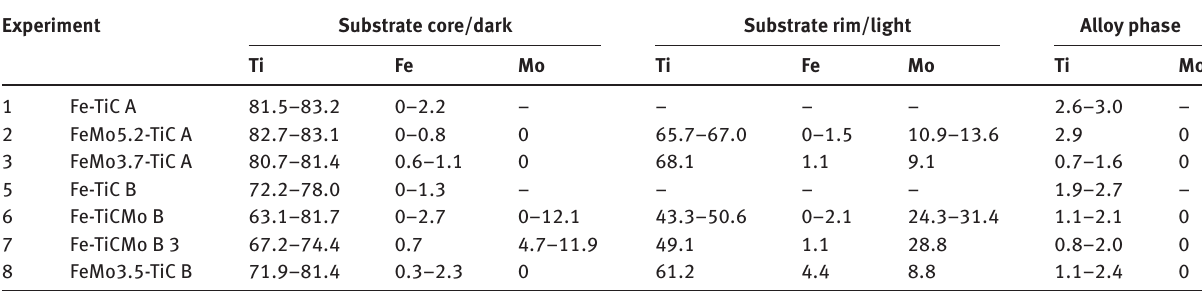
Table 3: Average analysis of TiC substrate and the alloy phase in the penetration zone (in mass%) Experiment